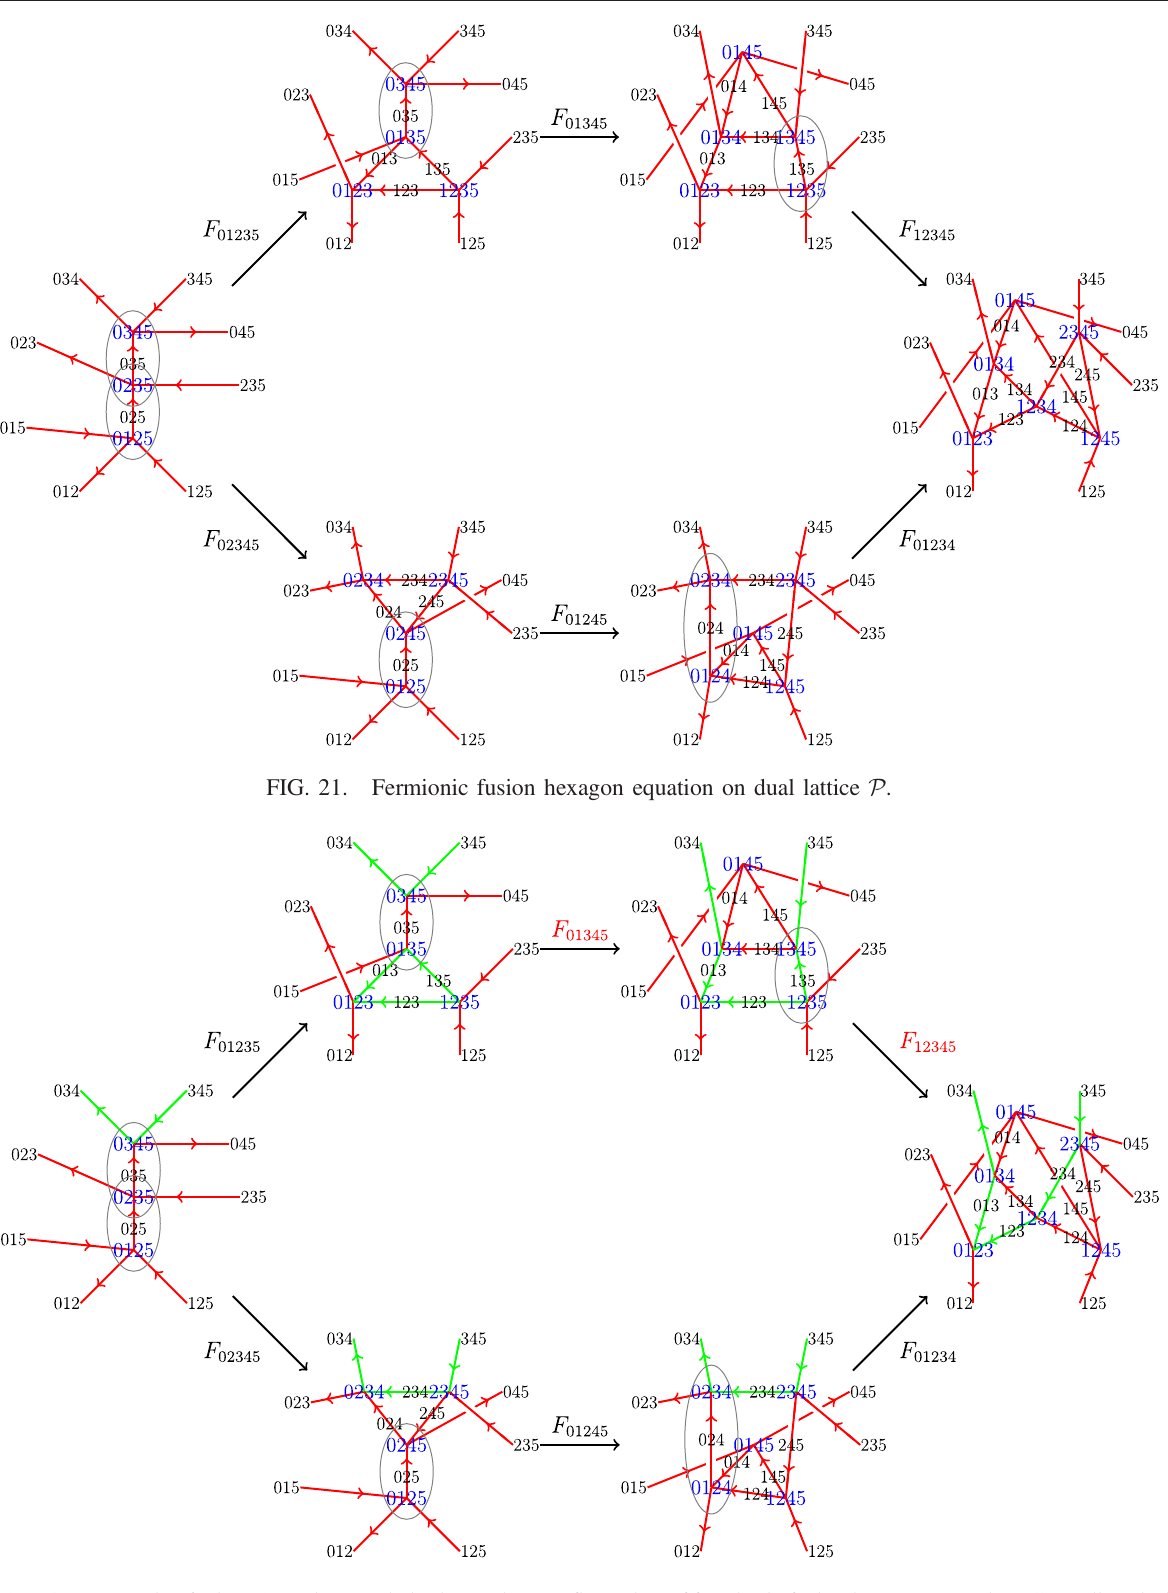
; g ; g belongs to the (0,1,1,0,0,0) row in i j k Þ